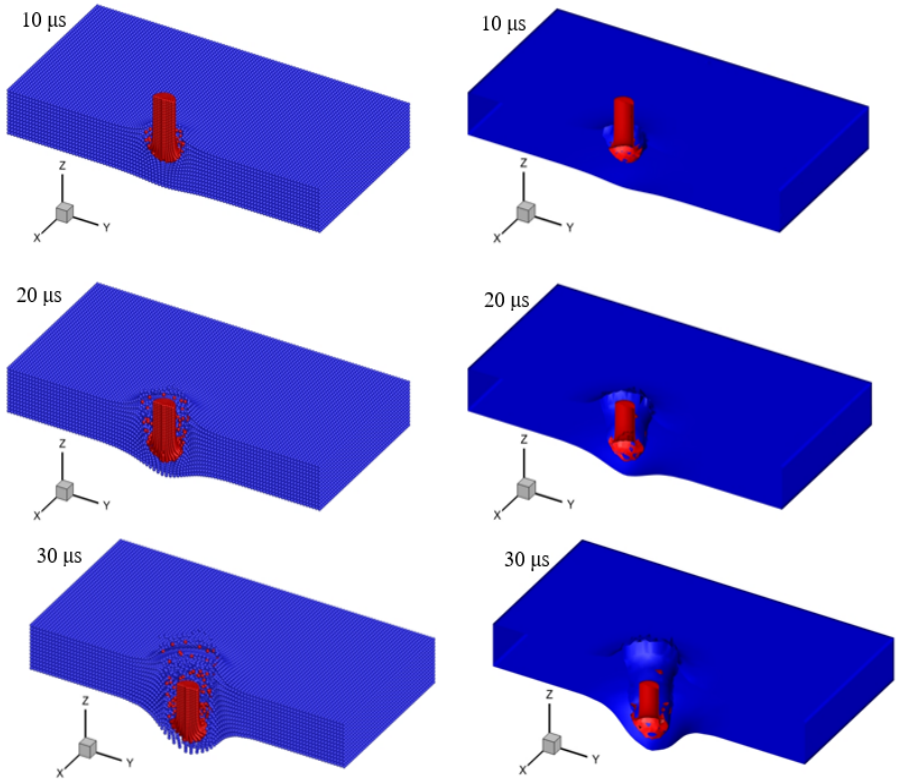
Figure 17. Particle distributions ( left ) and surfaces ( right ) of the ceramic plate and the projectile at different time.